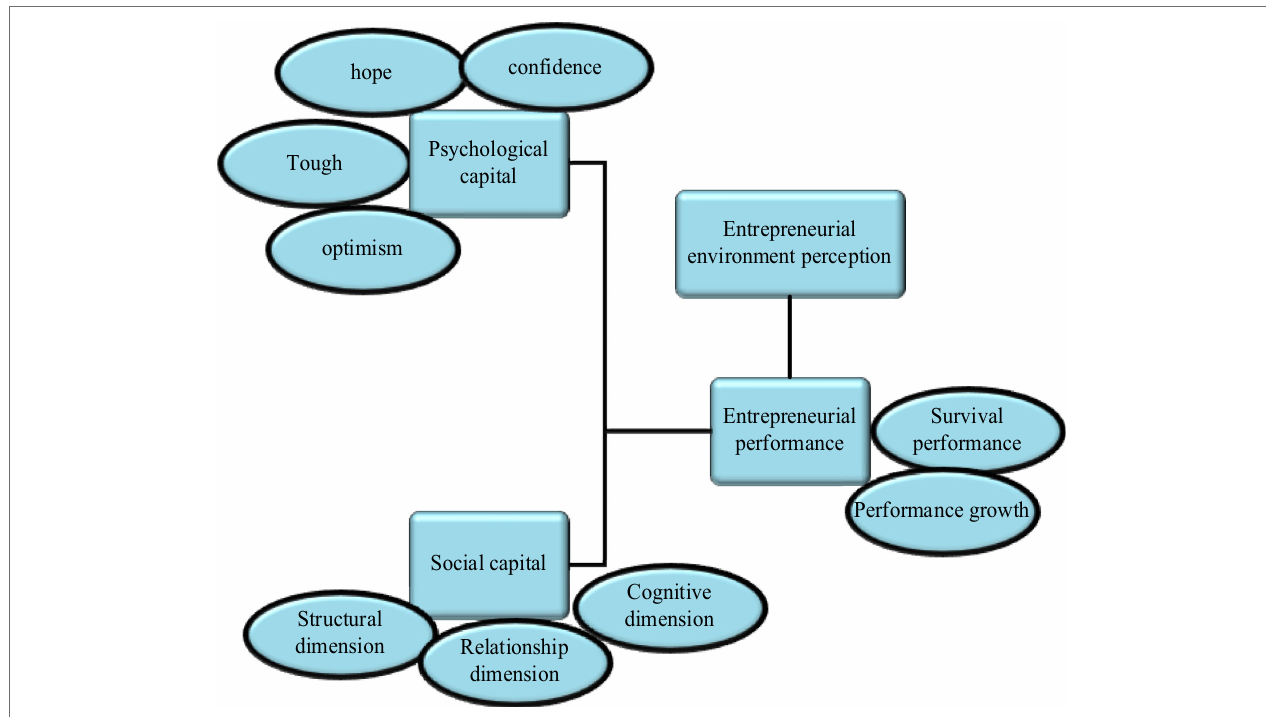
FIGURE 2 | Research model of psychological capital, social capital, and entrepreneurial